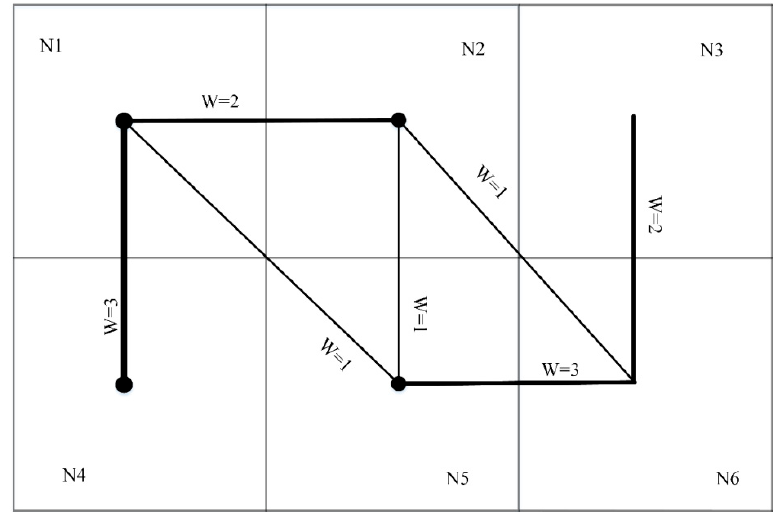
Figure 3. A sample of a community